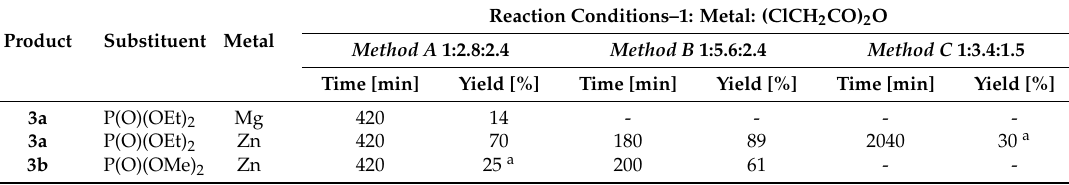
Table 1. Homodimerization of 3-dialkylphosphonocoumarins 1a – b under ultrasound irradiation.